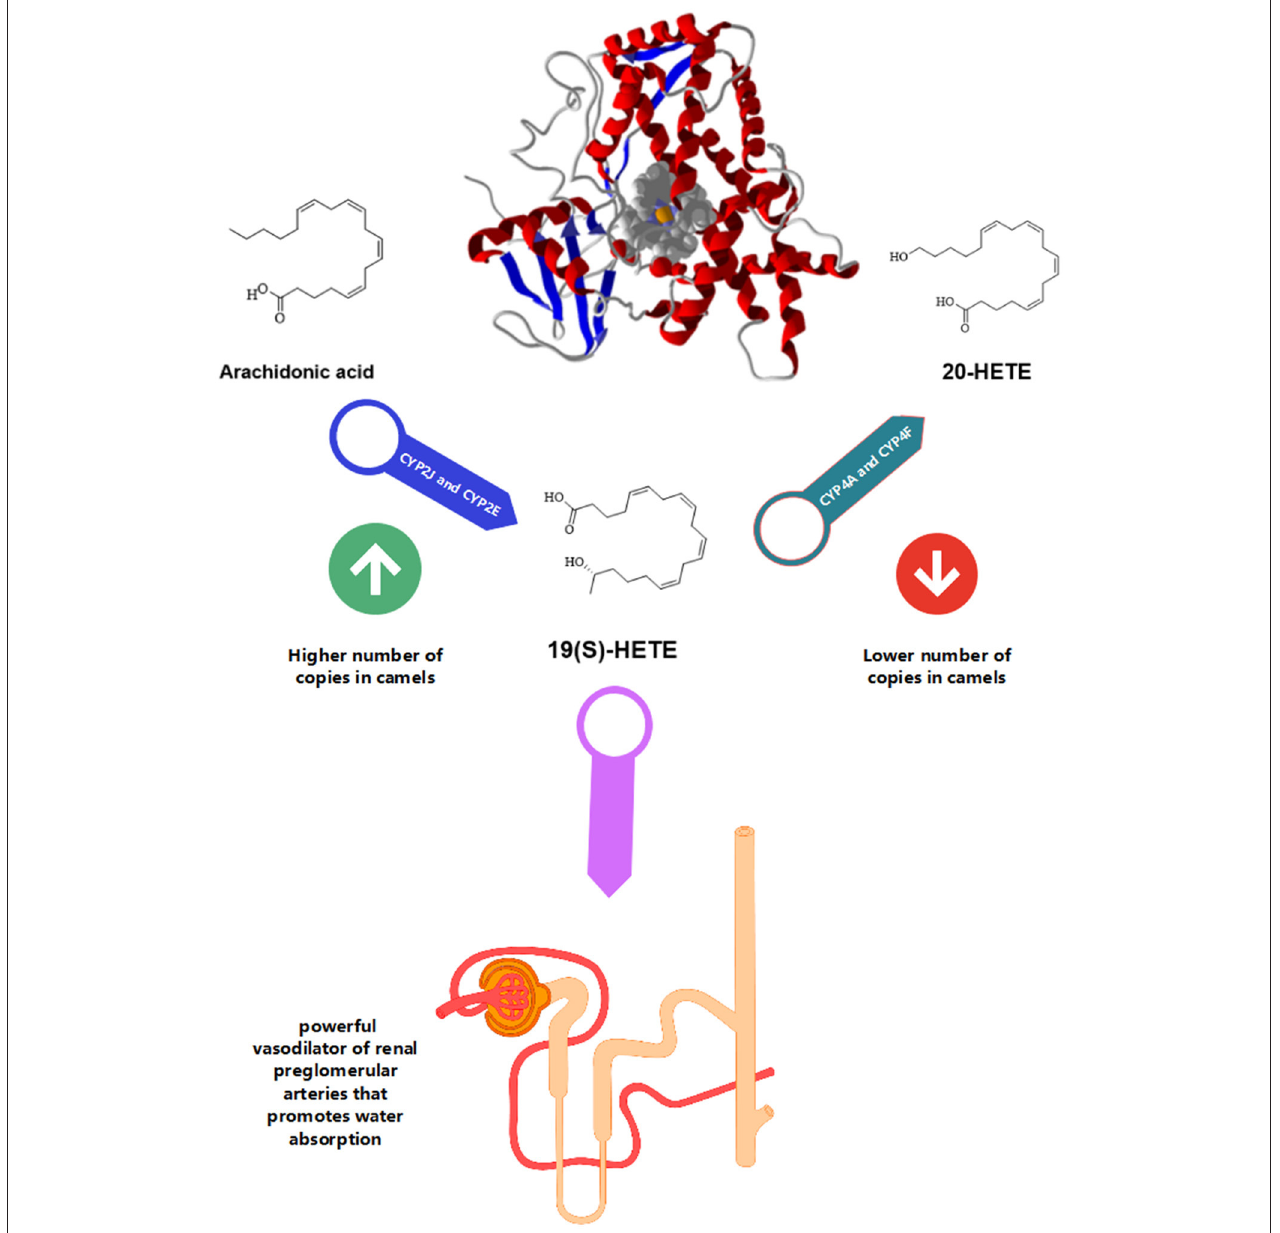
FIGURE 2 | Camel CYP450. The compound 19(S)-HETE is a powerful vasodilator of renal preglomerular arteries that promotes water absorption. There is a higher number of copies of CYP2J and CYP2E and a lower number of copies for CYP4A and CYP4F.